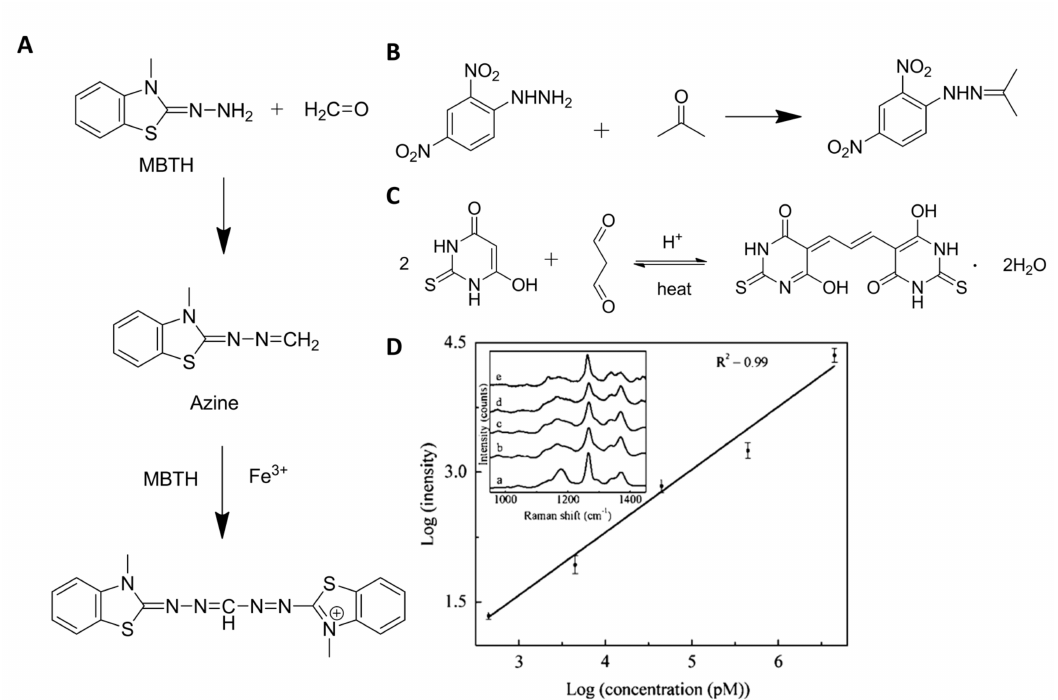
Figure 3. ( A ) Chemical derivatization reaction between MBTH hydrochloride and formaldehyde azine [20]; ( B ) Chemical derivatization reaction between acetone and 2,4-dinitrophenylhydrazine to form 2,4-dinitrophenyl hydrazine [17]; ( C ) Chemical derivatization reaction between thiobarbituric acid and malondialdehyde [21]; ( D ) Correlation between the SERS intensity at 1265 cm − 1 of HPLC-purified TBA-MDA adduct and its concentration in picomolar, both in logarithm scales. Inset: representative SERS spectra of TBA–MDA with concentration of (a) 4.5 µ M; (b) 0.45 µ M; (c) 45 nM; (d) 4.5 nM; and (e) 0.45 nM